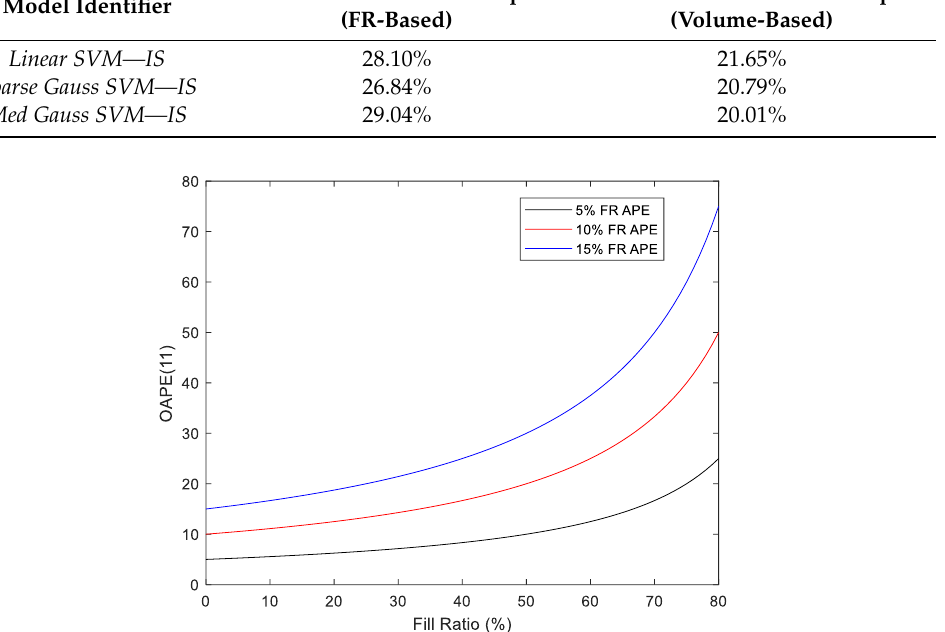
Figure 13. Residual volume-based overall average percentage error versus final fill ratio for various fill ratio absolute percentage error values.